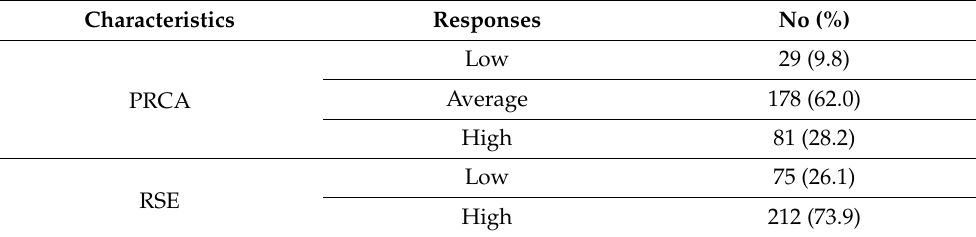
Table 5. The overall PRCA in the sampled students.